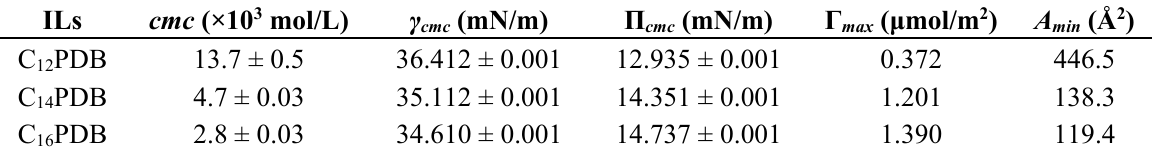
Table 1. Surface properties of C n PDB ( n = 12, 14, 16) in EAN at